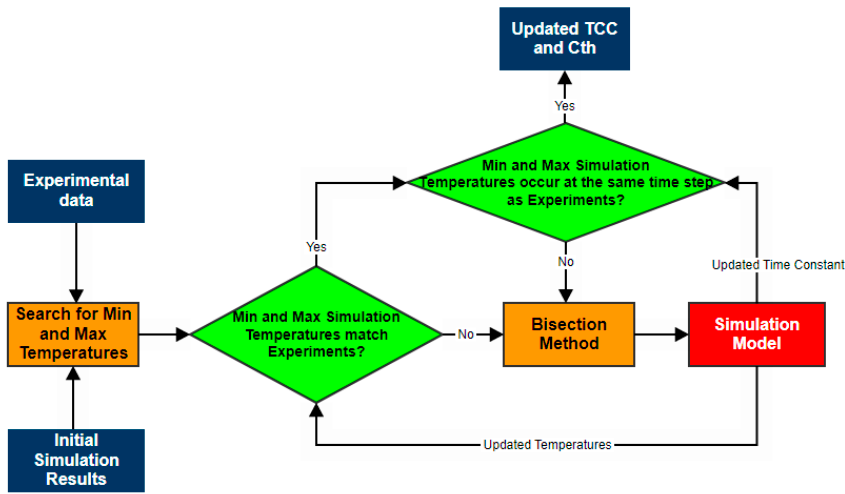
Figure 19. Flowchart of the algorithm employing for quantifying the process disturbances.